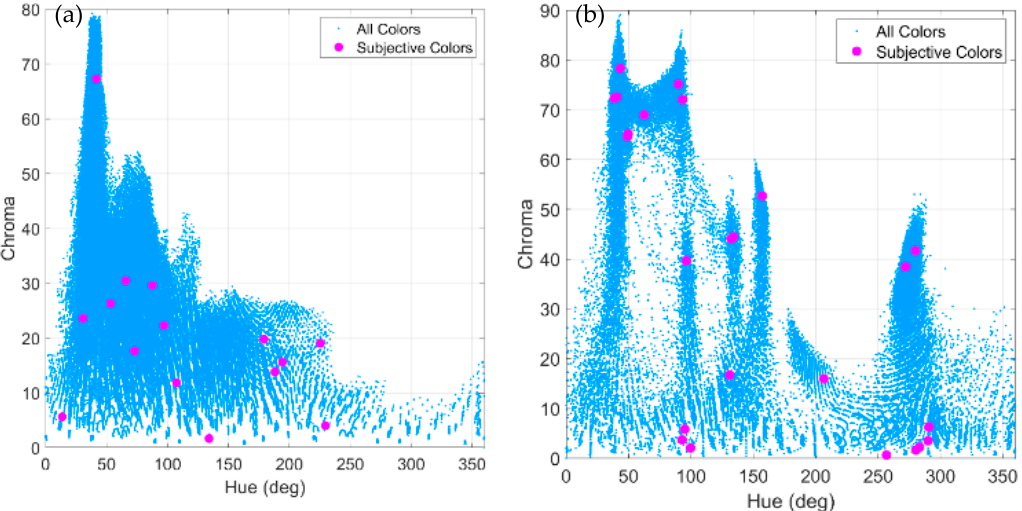
Figure 3. Distribution of hue versus chroma values for all the original colours and the subjective relevant colours selected by one observer for ( a ) The Crucifixion , and ( b ) Seated woman with wrist watch .